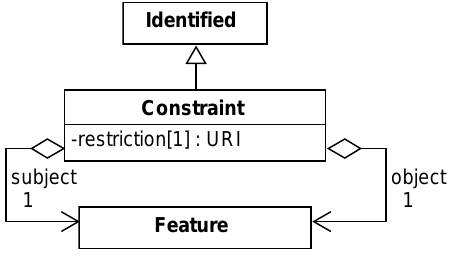
Figure 11: Diagram of the Constraint class and its associated